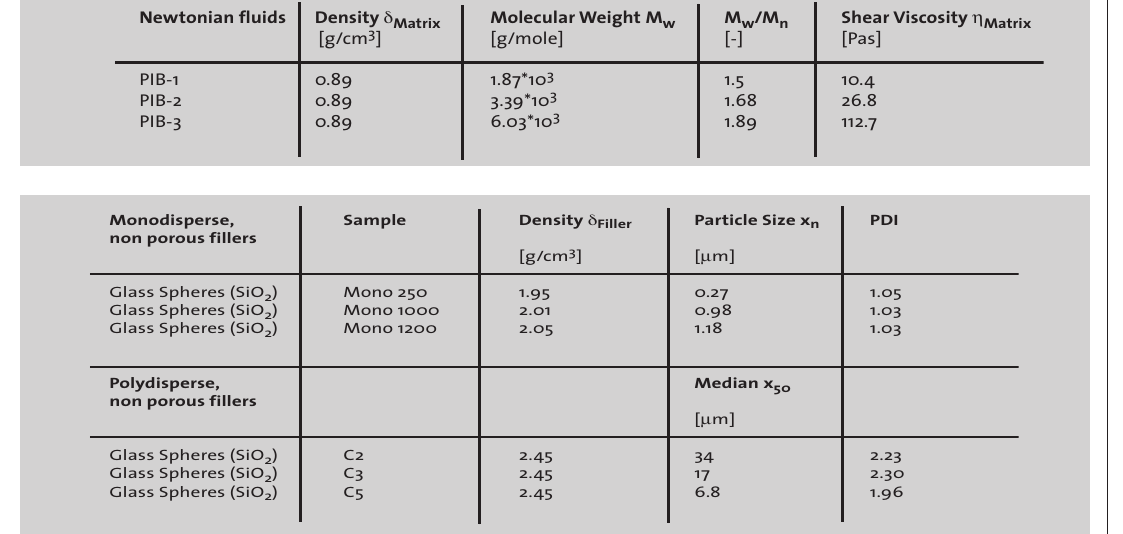
Tab. 1 (above): Newtonian matrix fluids of the model suspensions. Tab. 2 (below): Characteris- tic features of some of the used spherical